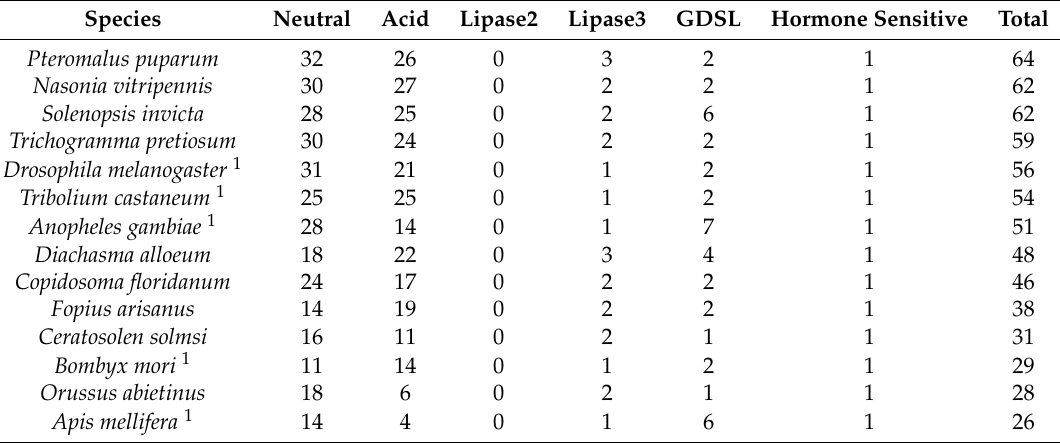
Table 1. Numbers of predicted lipase genes from each lipase family of selected insect species.